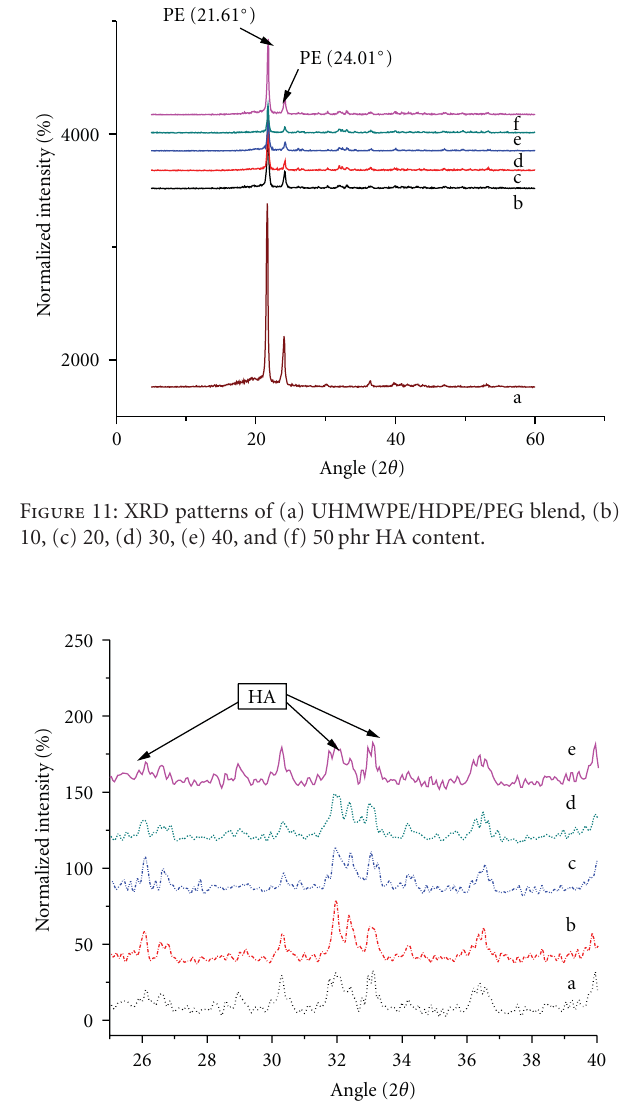
Figure 12: XRD patterns of UHMWPE/HDPE/PEG composites for (2 θ range from 25 to 40) (a) 10, (b) 20 (c) 30, (d) 40, and (e) 50 phr HA